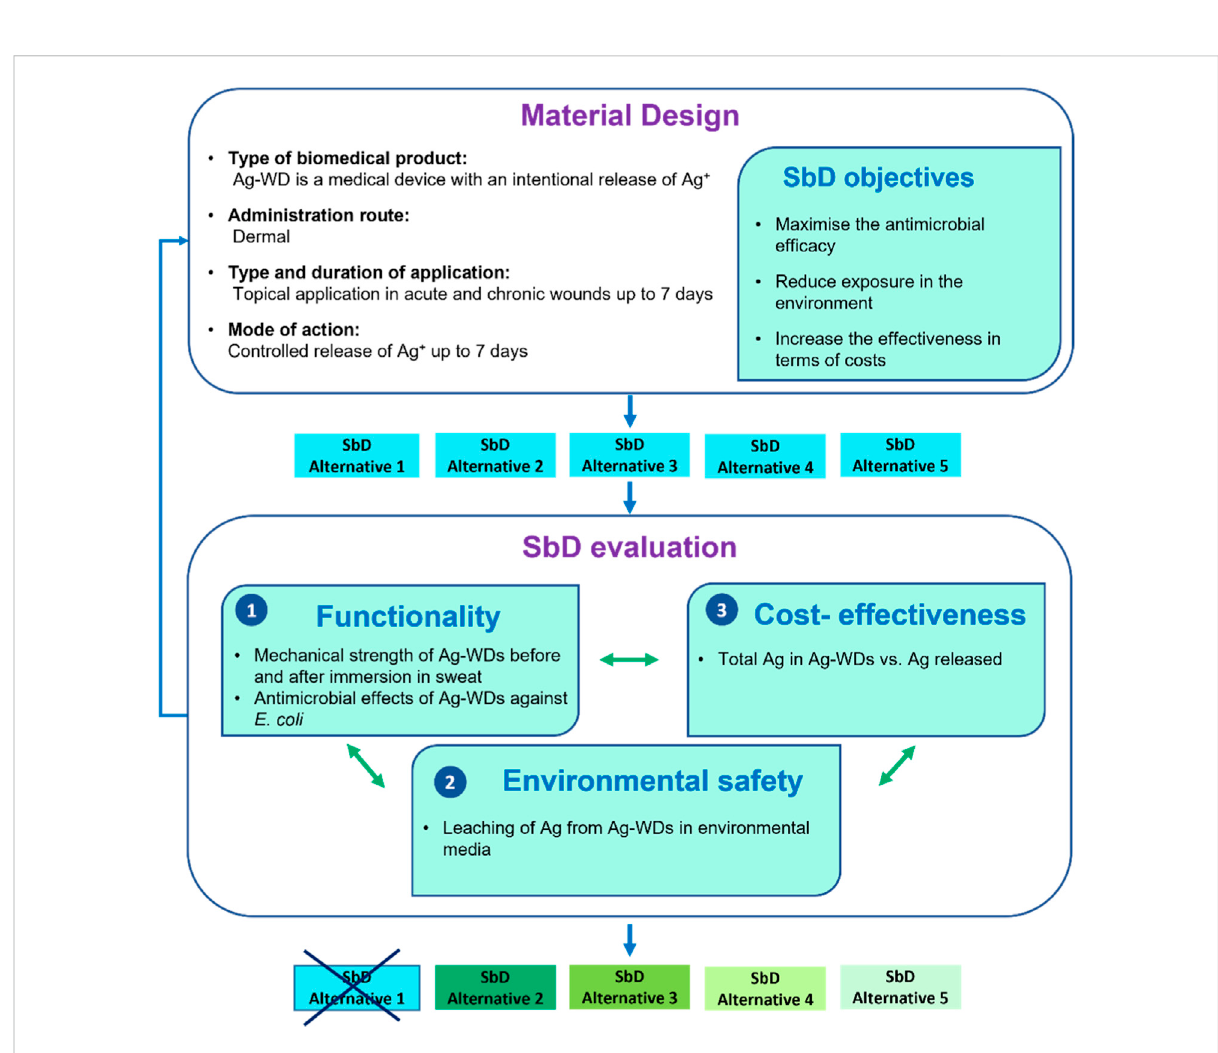
FIGURE 1 SbD procedure for topical wound dressing containing Ag